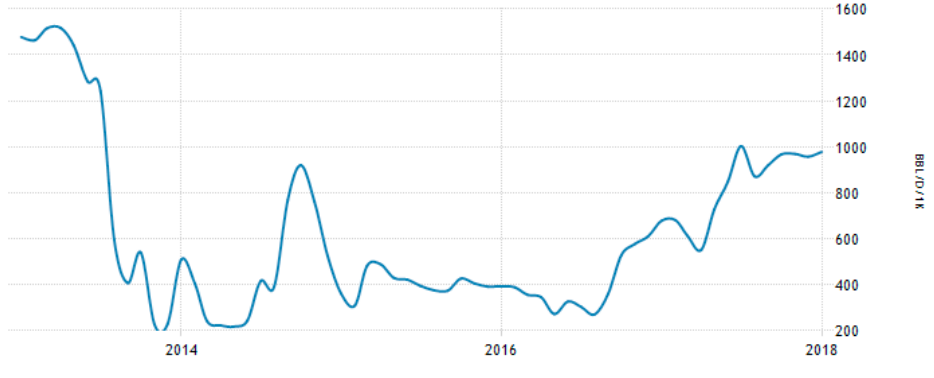
Figure 2. Libyan crude-oil production from 2012 to 2017 [24].